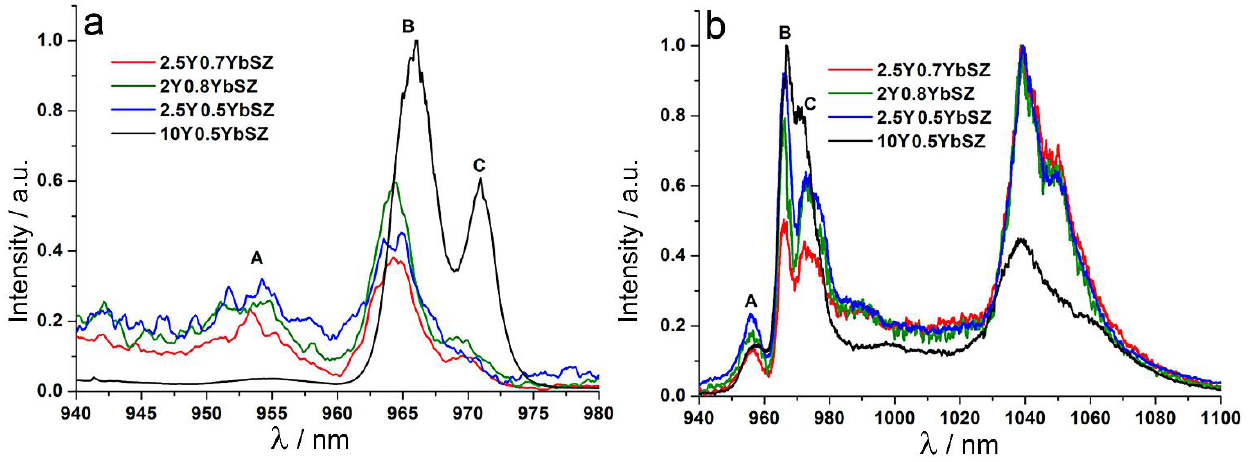
Figure 7. ( a ) 2 F 7/2 → 2 F 5/2 transition absorption spectra for Yb 3+ ions and ( b ) 2 F 5/2 → 2 F 7/2 transition luminescence spectra for Yb 3+ ions, λ ex = 907 nm, T = 300 K, for 2Y0.8YbSZ, 2.5Y0.5YbSZ, 2.5Y0.7YbSZ and 10Y0.5YbSZ crystals.